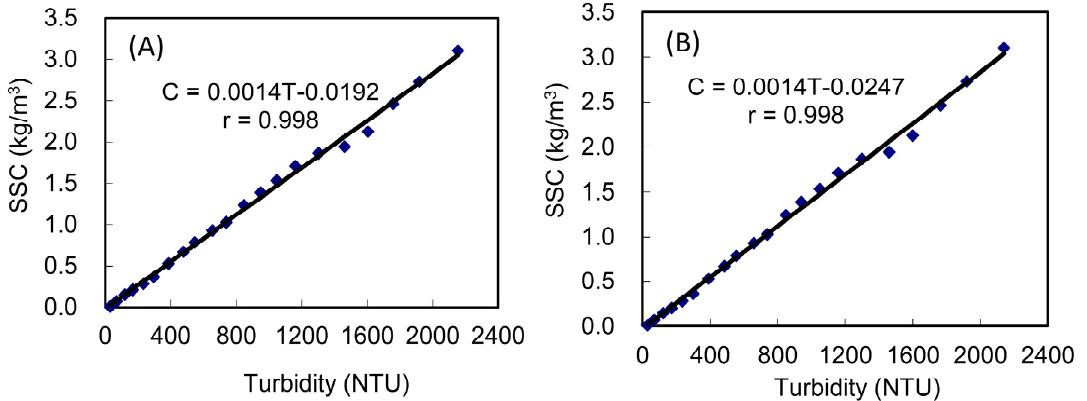
Figure 2. ( A ) Relationship between SSC (C) and OBS turbidity (T) in summer, and ( B ) Relationship between SSC (C) and OBS turbidity (T) in winter.